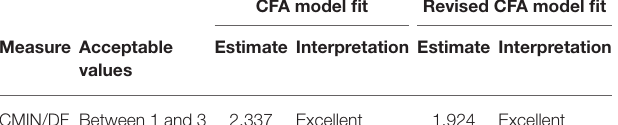
TABLE 7 | SEM model fit indices.